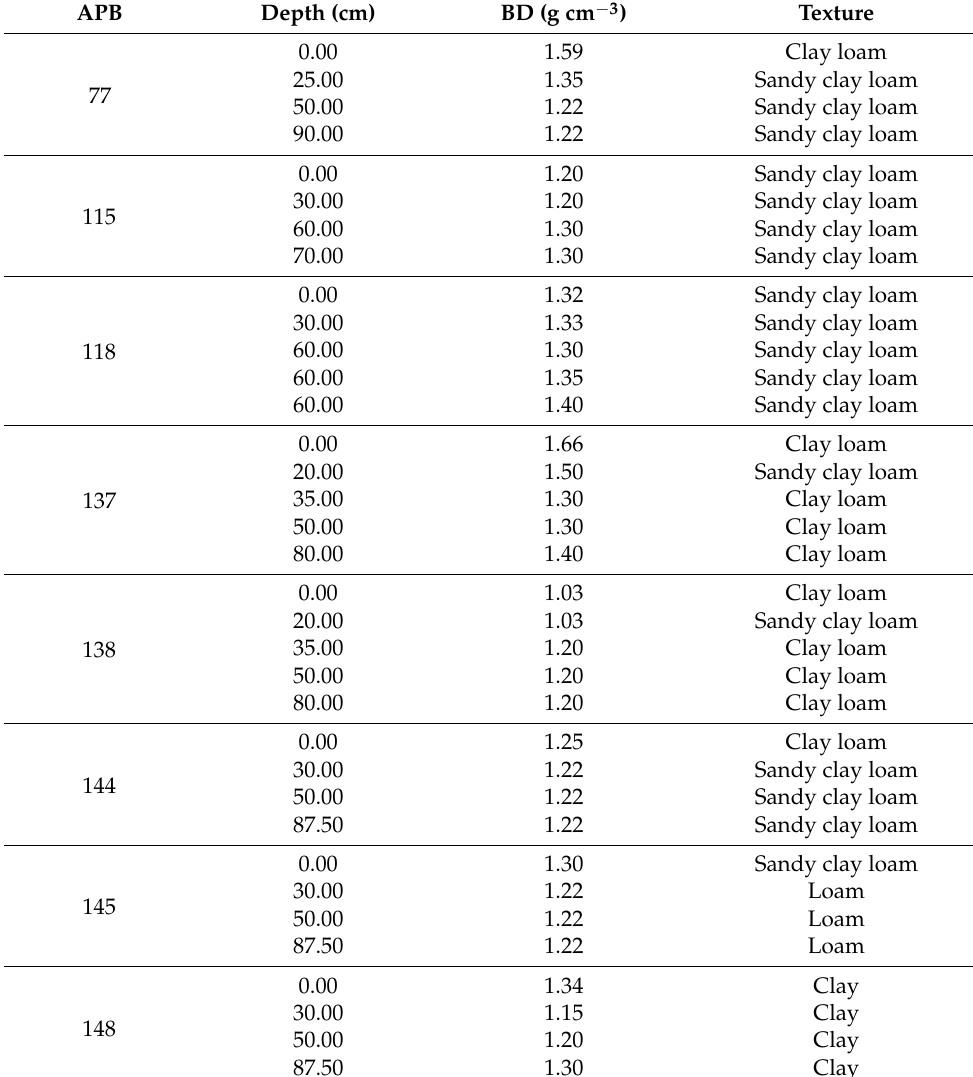
Table 1. Soil texture and bulk density of selected